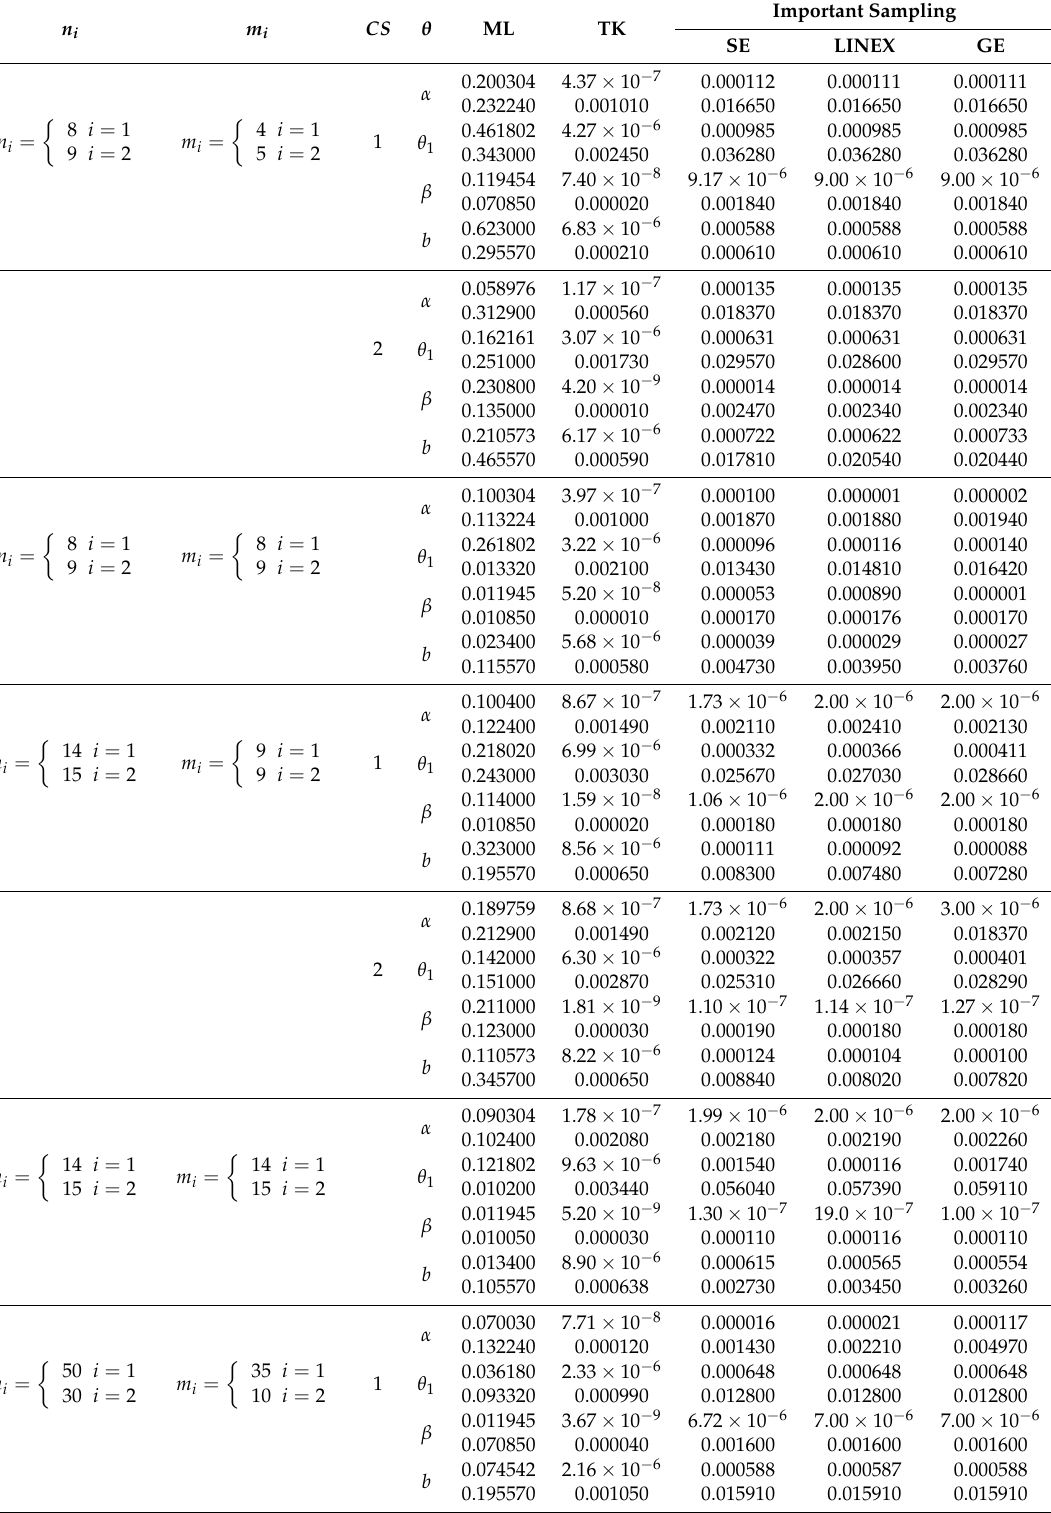
Table 4. Mean square errors (MSEs) and relative absolute biases (RABs) for MLEs and BEs of α , θ 1 , γ , and b with true values ( γ = 1.4, α = 0.5, θ 1 = 0.7 and b = 1.2), values of hyper-parameters ( µ 1 = 196000, µ 2 = 2500, µ 3 = 490, µ 4 = 1440, λ 1 = 7.1428 × 10 − 6 , λ 2 = 0.0002, λ 3 = 0.0014, and λ 4 = 0.0008), k = 2, ν 1 = 10 and ν 2 =